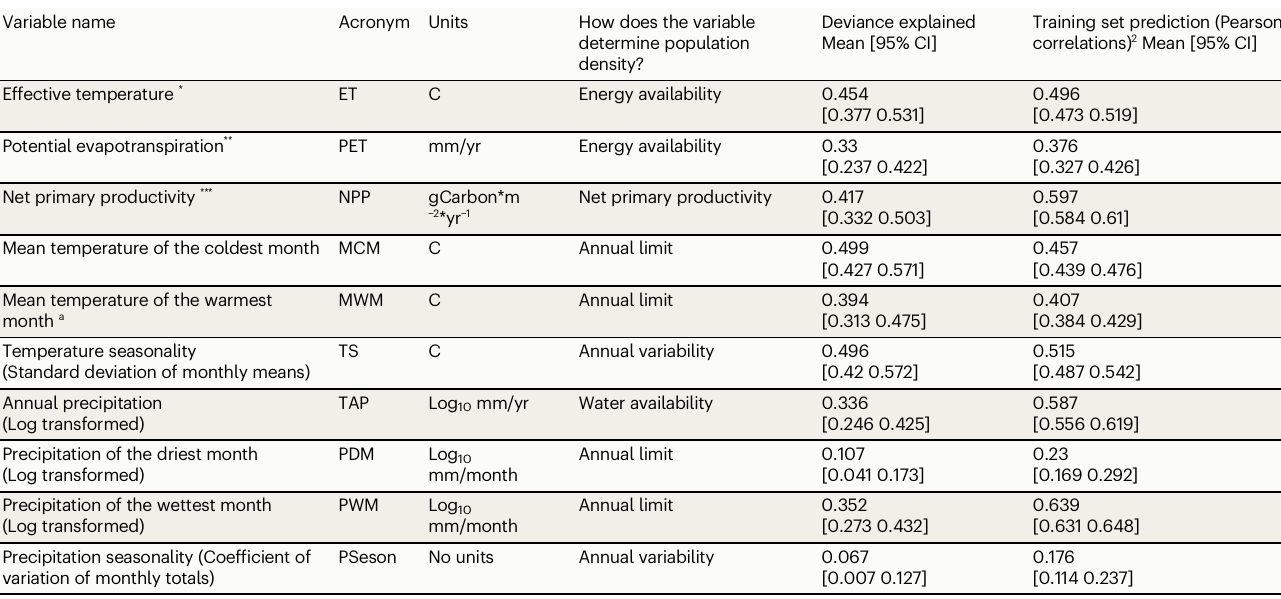
Table 1 | Variables used to generate ethnographic-based models of the effect of climate on hunter-gatherer population density and summary of cross-validated deviance explained and predictive accuracy for the evaluated